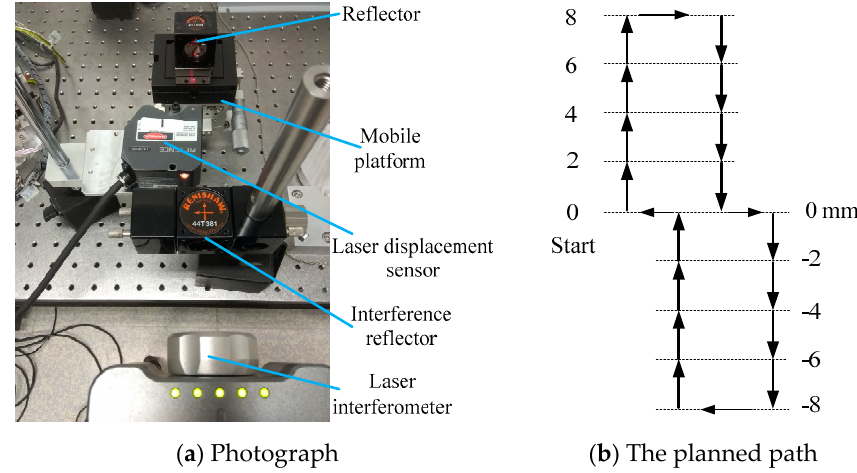
Figure 6. Photograph of the measurement comparison between the laser sensor and laser interferometer.